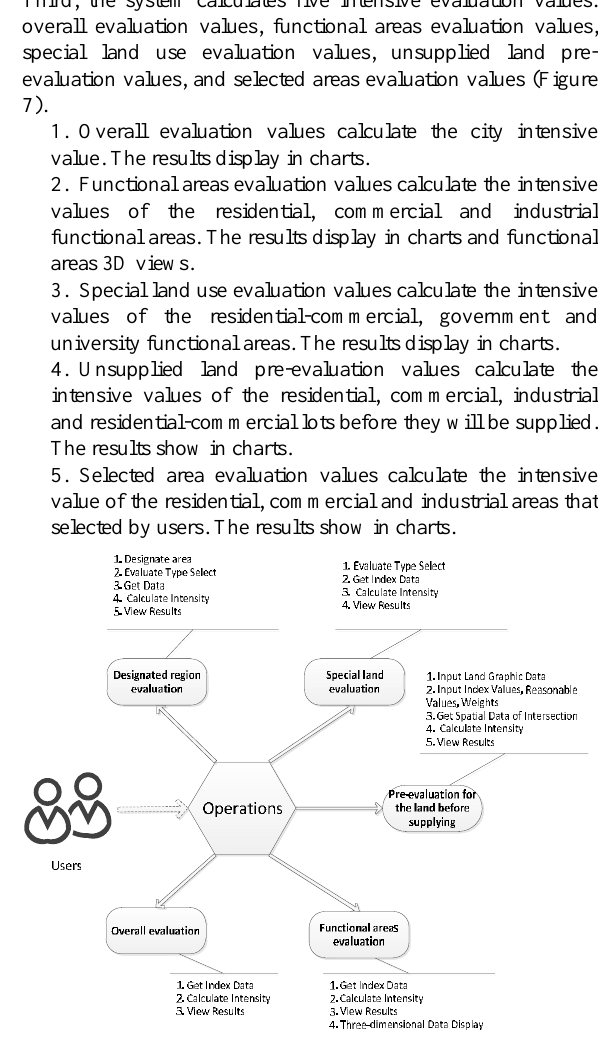
Figure 7. Intensive evaluate function